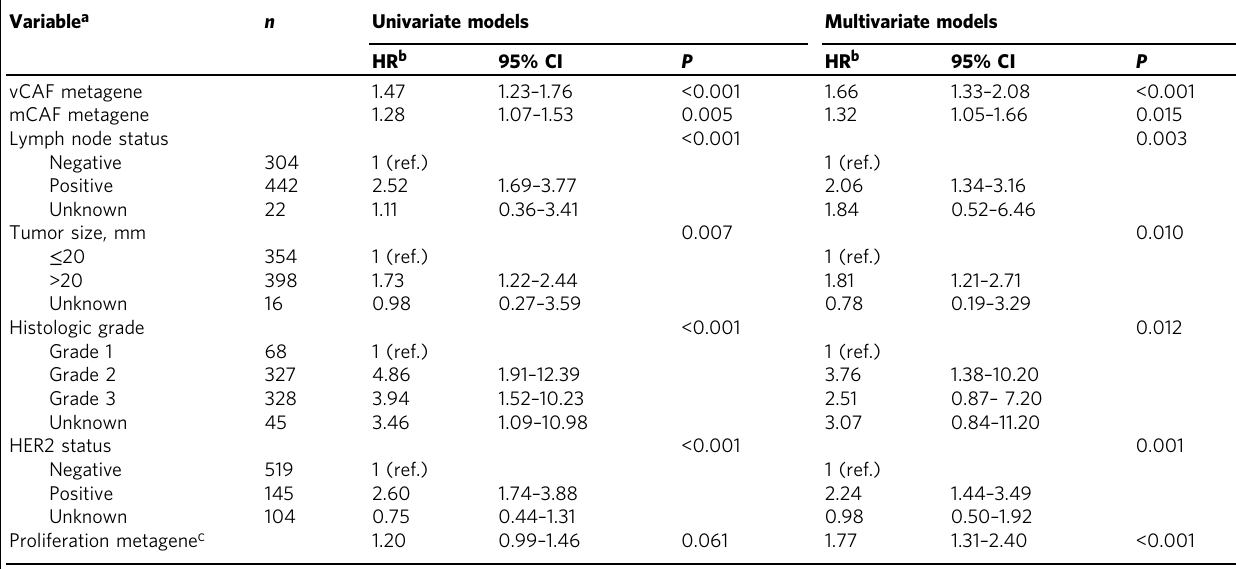
Table 1 Univariable and multivariable conditional logistic regression models comparing patients developing metastatic disease with patients free from disseminating disease in a nested case – control study Variable a n Univariate